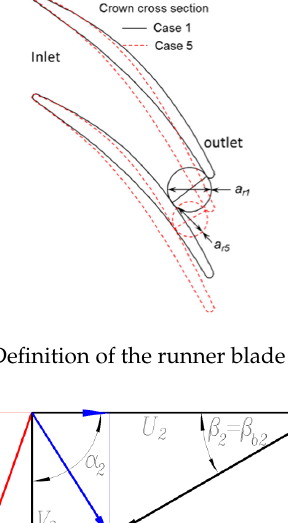
Figure 8. Velocity triangle at runner outlet.